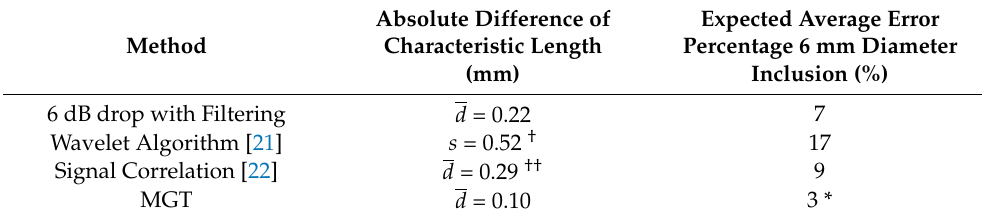
Table 5. Comparison of MGT method with other Manufactured Defect Sizing